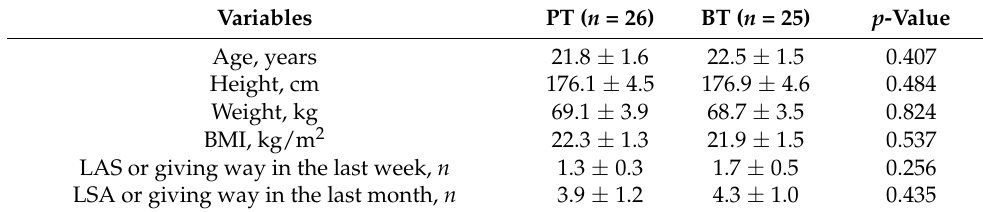
Table 2. General characteristics of participants.